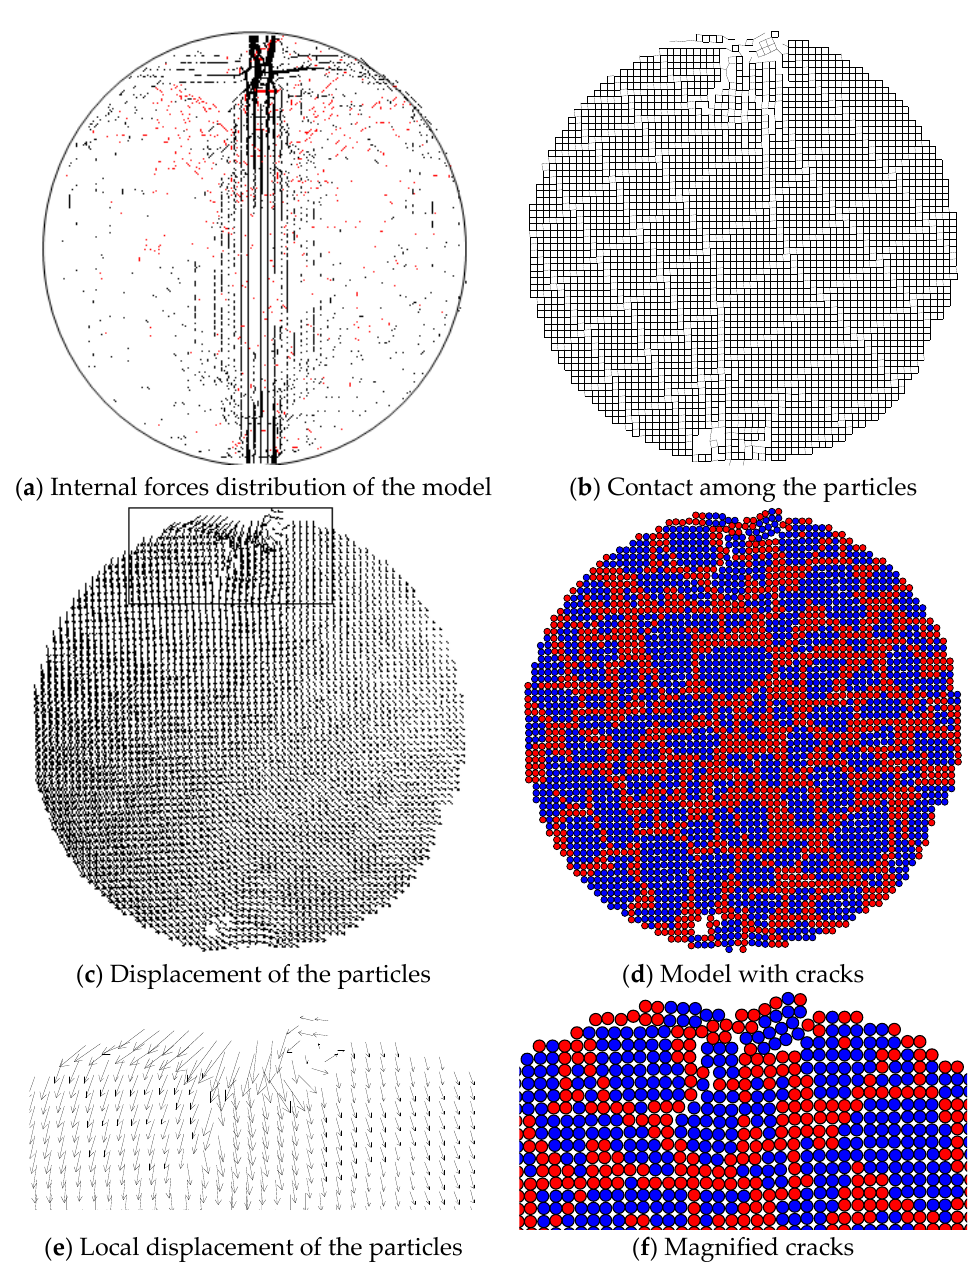
Figure 9. Crack initiation.